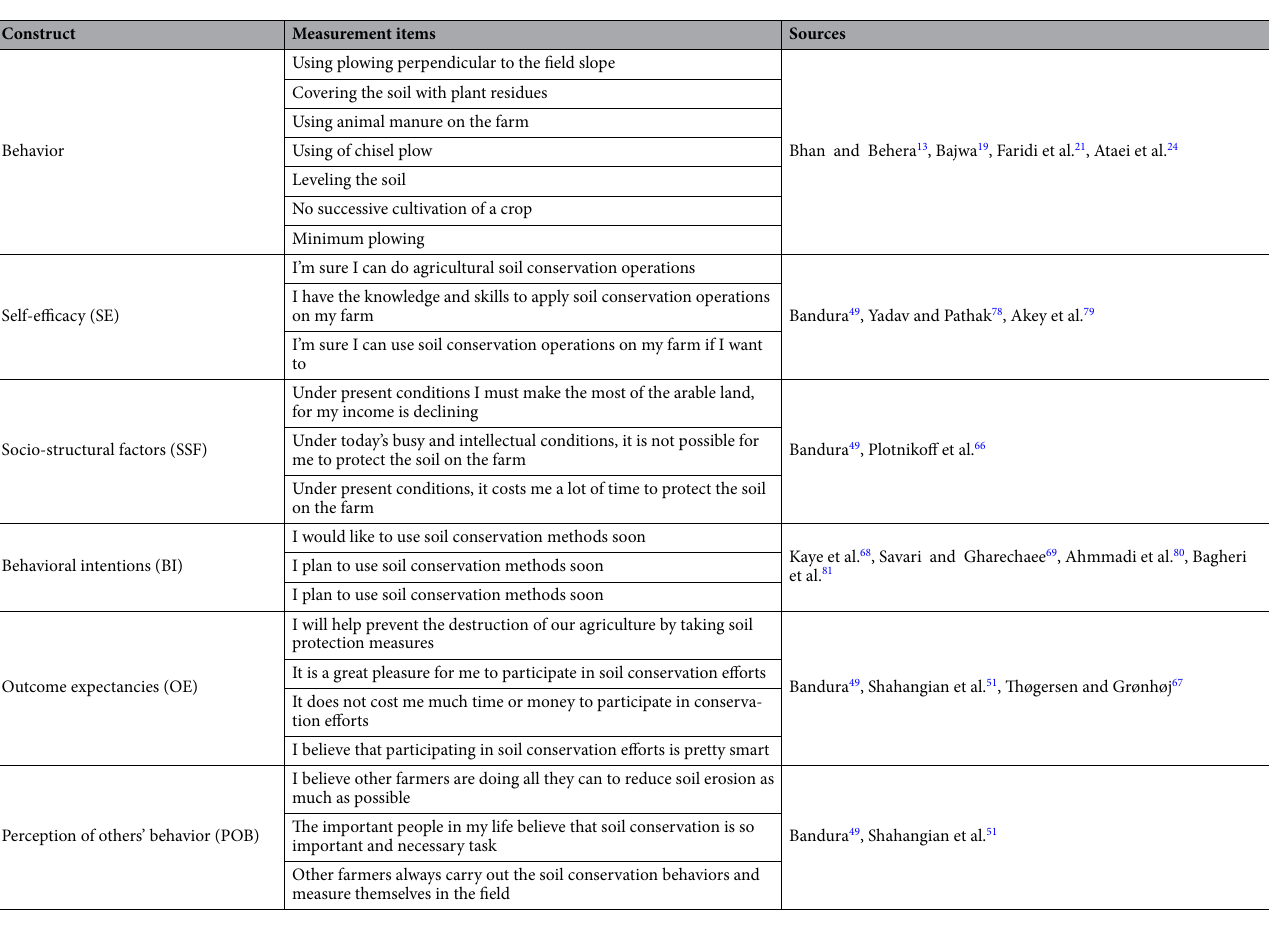
Table 1. Variables of research.